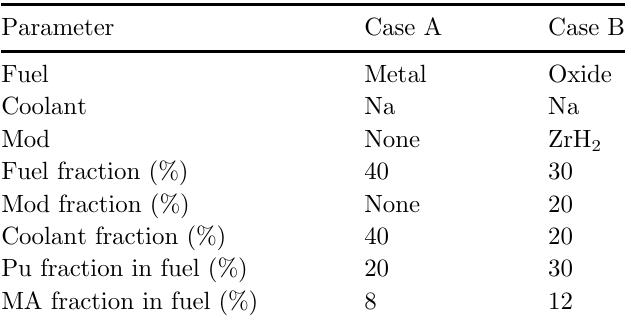
Table 6. Details of the cases used for the fuel cycle